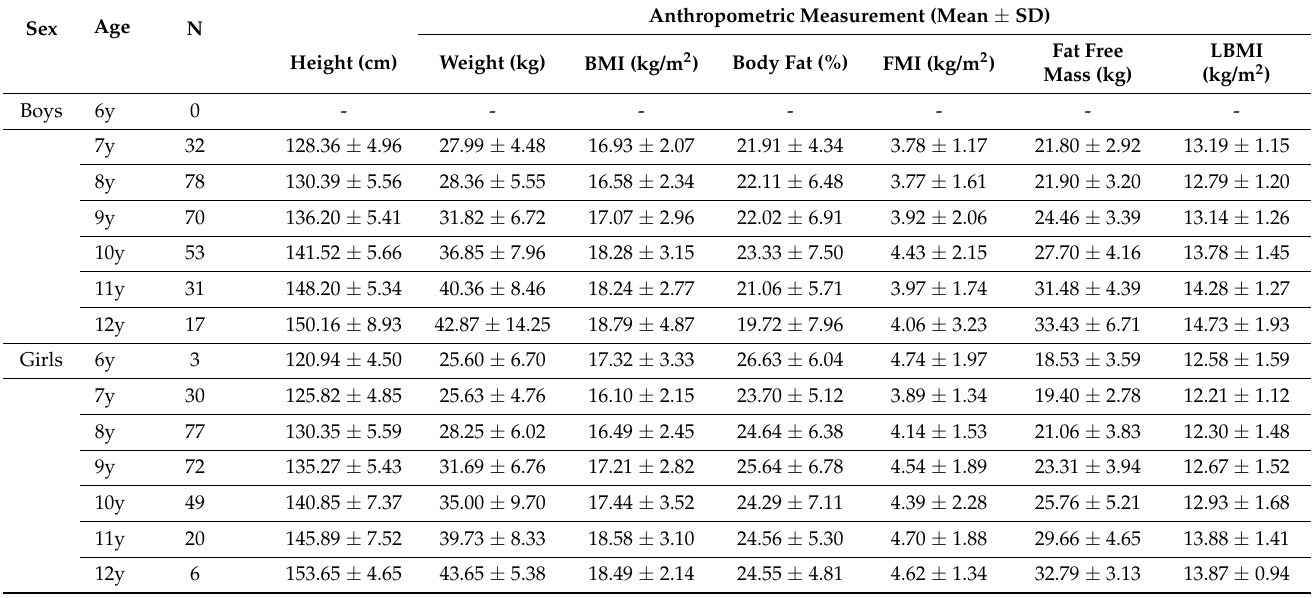
Table A2. Characteristic of the sample (anthropometric measurements) according to age and sex.